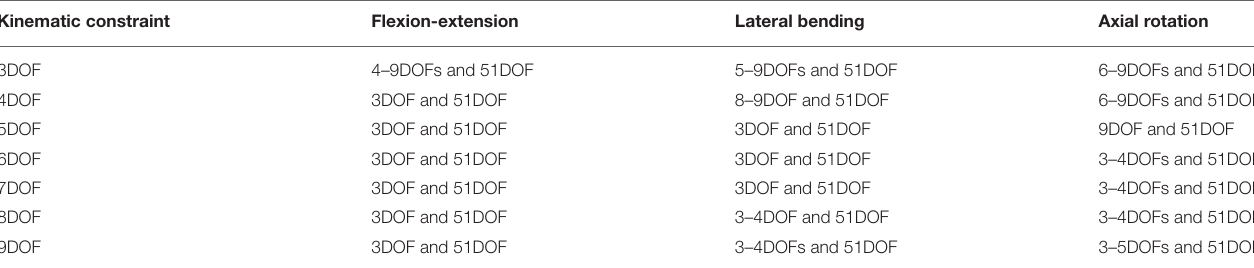
TABLE 4 | Significant post-hoc pairwise comparisons (Tukey’s HSD) of kinematic constraints for RMS error of spine markers in each task shown in Figure 1 . Kinematic constraint